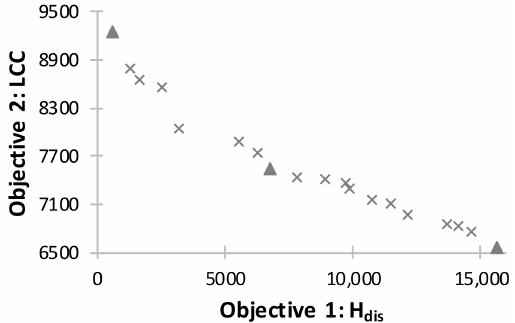
Figure 5. Pareto front for case 2 (triangle–MCDM solutions).